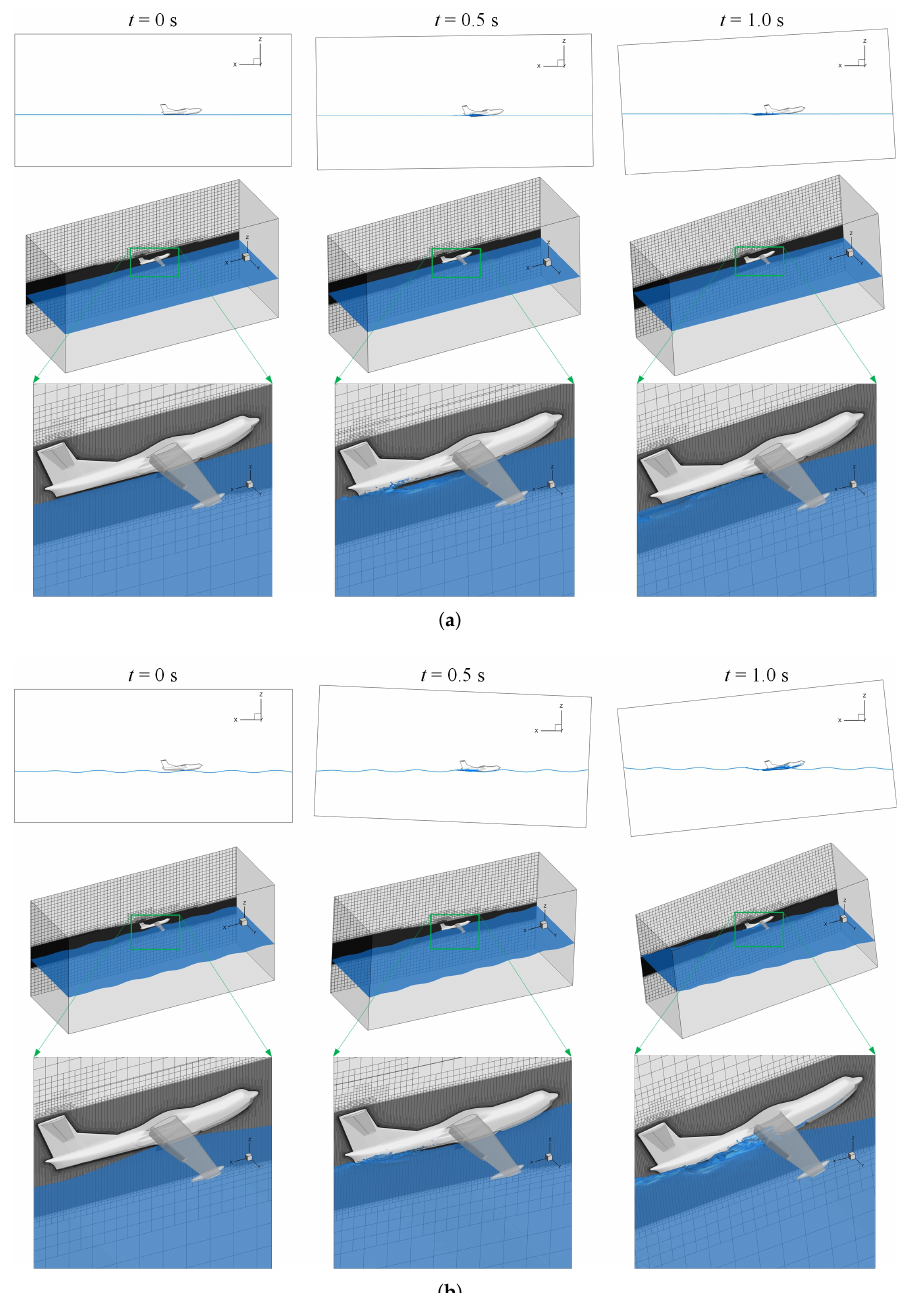
Figure 9. Comparison of transient snapshots ( t = 0, 0.5 and 1.0 s) of whole computational domain movement, free surface evolution and mesh around the aircraft model: ( a ) calm water-landing; ( b ) wave crest landing. The rectangular box is the computation domain; blue line and surface are the air-water interface; all snapshots are in the same ground-fixed coordinate XYZ with same